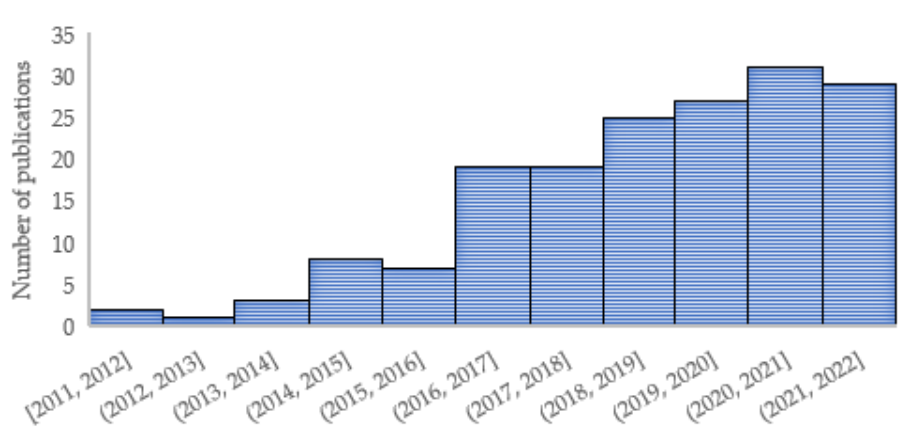
Figure 1. The number of publications in physics-based urban building energy modeling per year since 2011 based on the Scopus search platform.